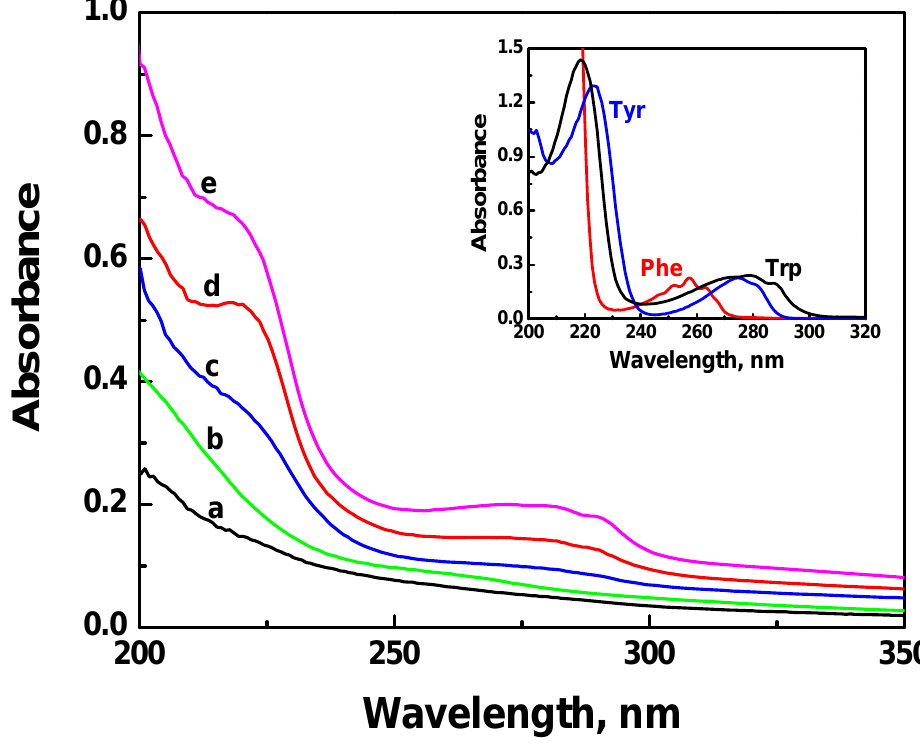
Figure 1. Absorption spectra of aqueous suspension of ONC: ( a ) alone, and coupled with: ( b ) Phe, ( c ) EMP, ( d ) Trp and ( e ) WRF. The insert shows the absorption spectrum of Trp